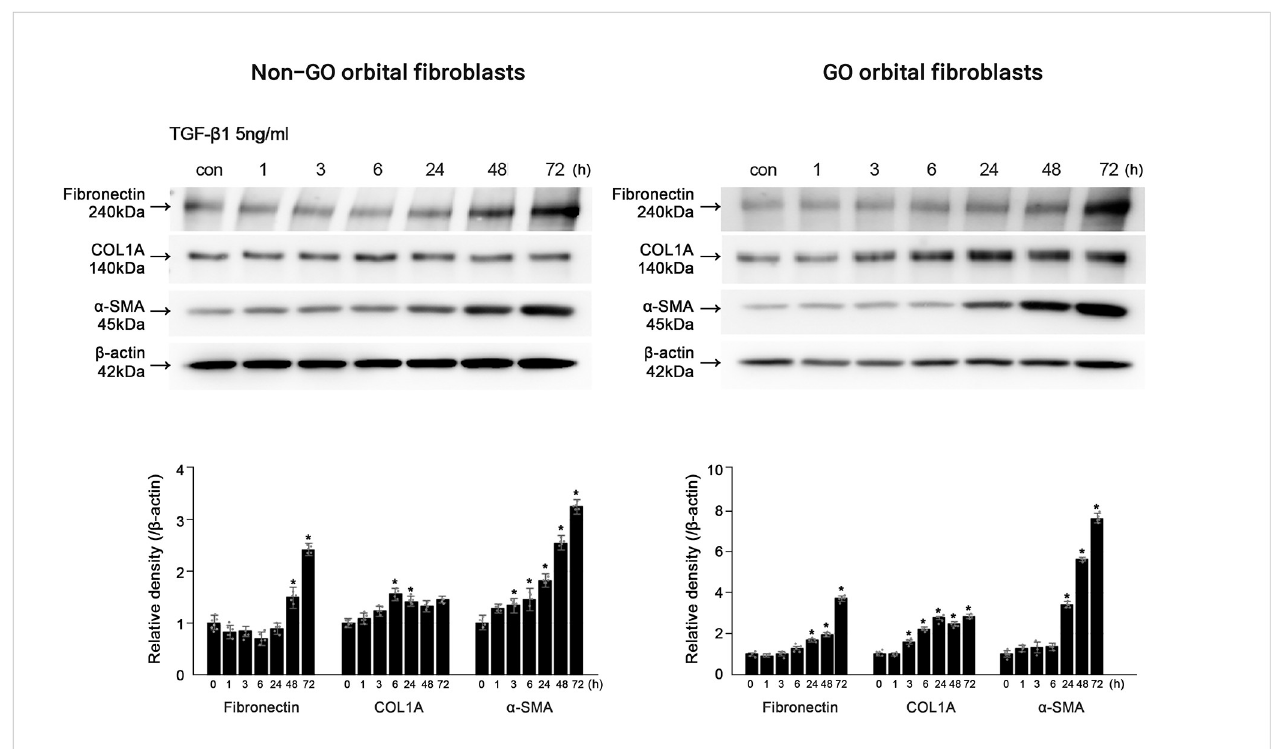
Fig 2. Effect of transforming growth factor (TGF)- β 1 on fibrosis-related protein production in the Graves 0 orbitopathy (GO) and non-GO orbital fibroblasts (OFs). After treatment of the OFs with 5 ng/mL TGF- β 1 for 0, 1, 3, 6, 24, 48, and 72 h, the protein expression levels of fibronectin, collagen I α , α - smooth muscle actin increased in a time-dependent manner. Bar graphs show the relative density of each protein normalized to the level of β -actin and are represented as mean ± standard deviation. Experiments were performed using at least cells using different strains. � p < 0.05.